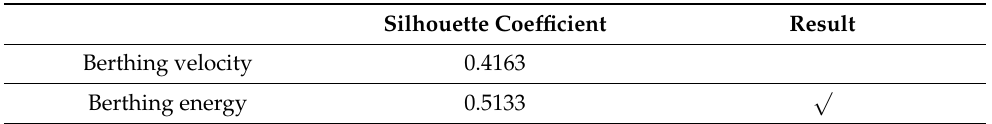
Table 6. Silhouette